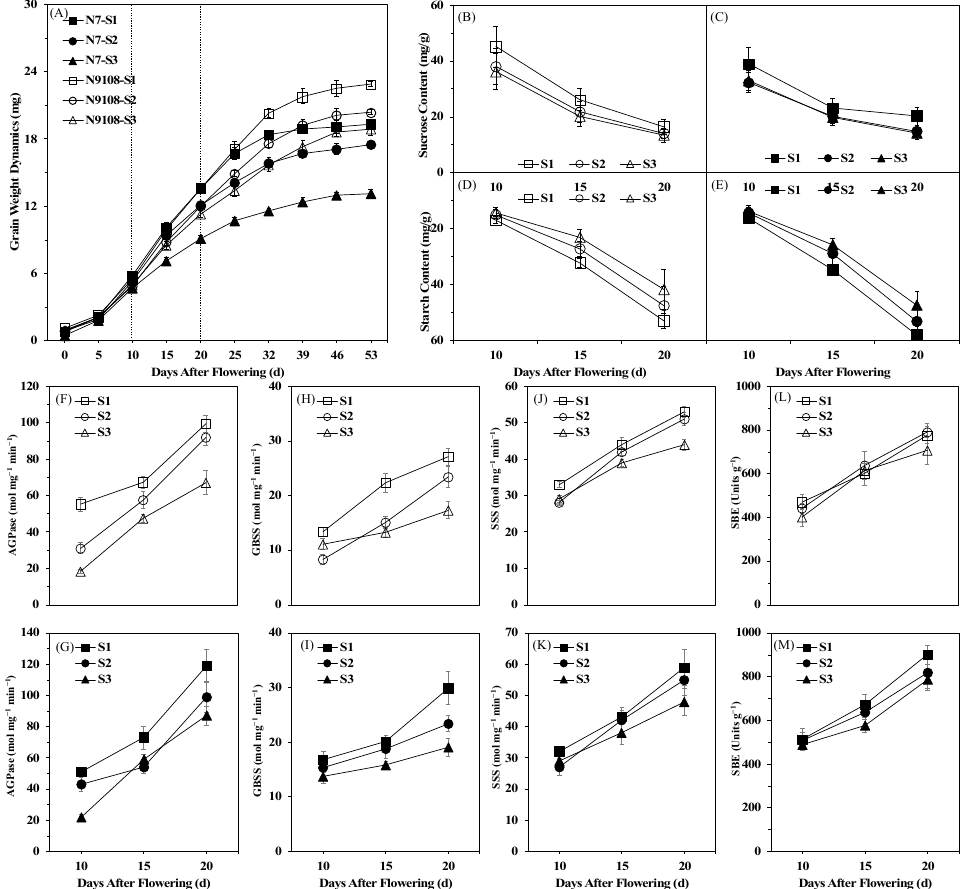
Figure 3. Grain filling dynamics and starch biosynthesis activity dynamics of grains located on different positions and sowing dates of japonica rice varieties. ( A ) Grain filling dynamics; ( B , C ): sucrose content dynamics; ( D , E ): starch content dynamics; ( F , G ): AGPase activity; ( H , I ): GBSS activity; ( J , K ): SSS activity; ( L , M ): SBE activity. Note: Black dots represented N7 and white dots indicated N9108. Note: AGPase represents ADP-glucose pyrophosphorylase; SSS represents soluble starch synthase; GBSS represents granules bound starch synthase; SBE represents starch branching enzyme. 253 Table 1. Correlation analysis among grain quality, filling characteristics and enzyme activities. 254 (a) Correlations between Filling Characteristics and Taste Quality Parameters